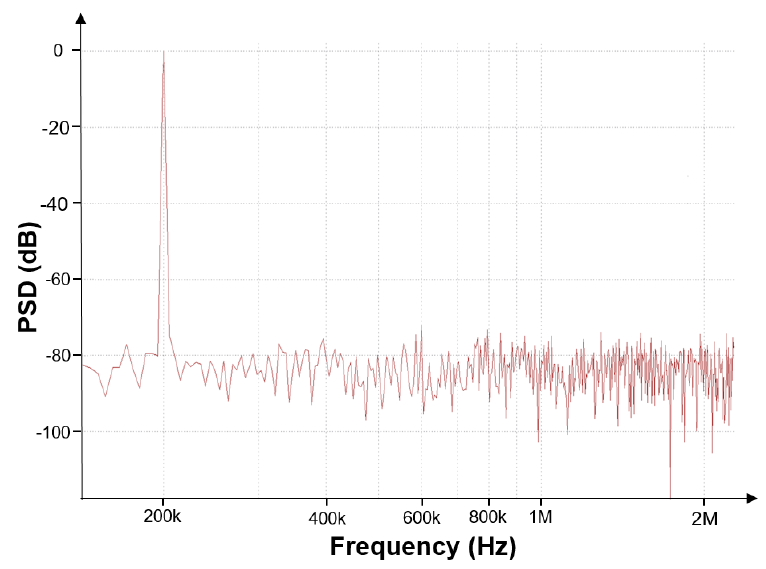
Figure 21. Post-layout simulated PSD of the proposed PLL-SAR ADC. Table 2. Post-layout simulated results of the proposed PLL-SAR ADC circuit with three design corners.